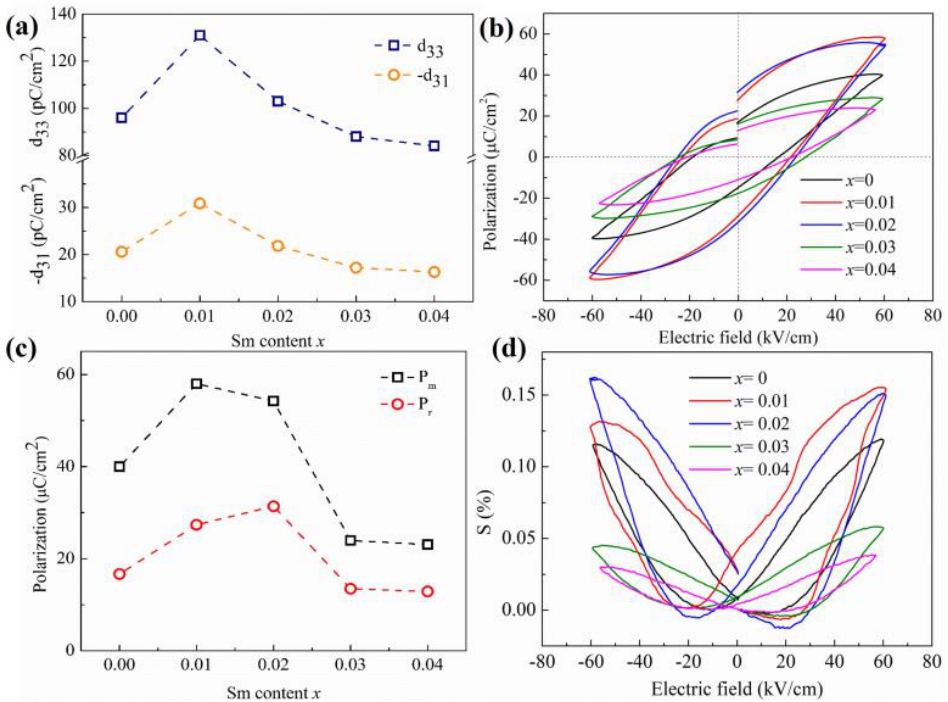
Figure 5. ( a ) Longitudinal piezoelectric coefficient ( d 33 ) and the transverse piezoelectric coefficient ( − d 31 ) of porous BNBT6- x Sm ceramics. ( b ) Hysteresis loops of porous BNBT6- x Sm ceramics. ( c ) Po- larization including P m and P r . ( d ) Strain–electric loops of porous BNBT6- x Sm ceramics at 60